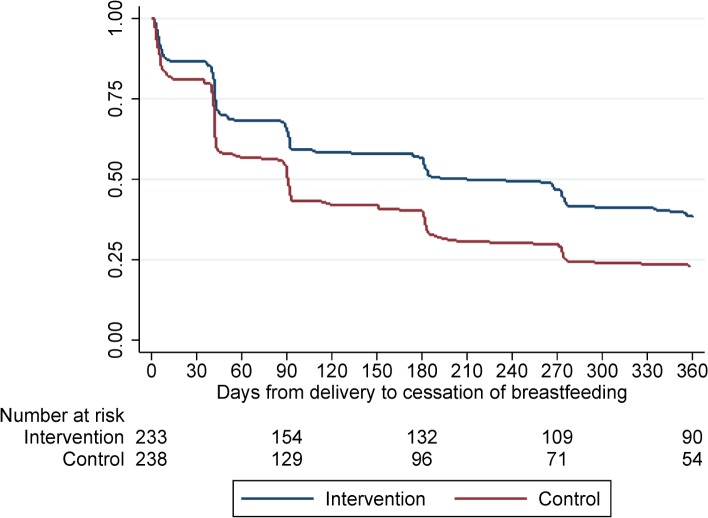
Time to cessation of any breastfeeding for women in the intervention and control arms.Log-rank test, p = 0.006.